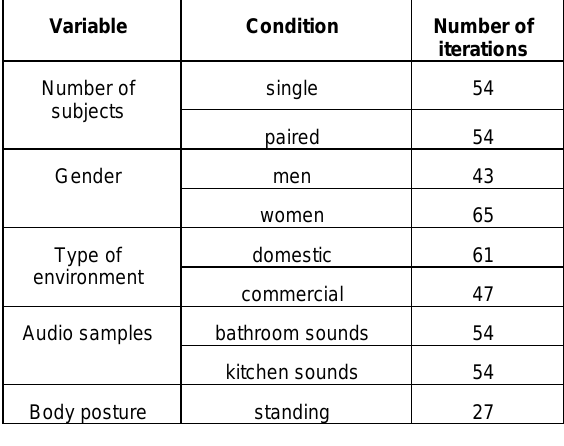
Table 1. Experimental conditions and activities.